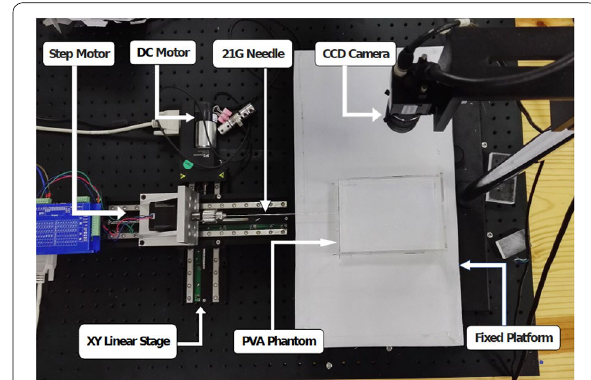
Figure 4 Experimental testbed for needle insertion procedures